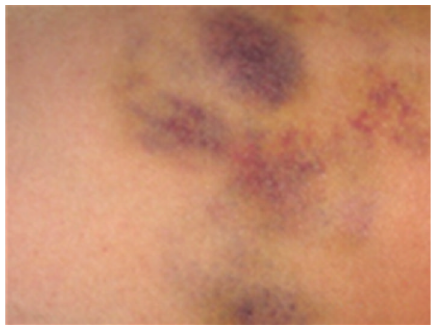
Figure 2: Ecchymoses of the patient’s right leg.